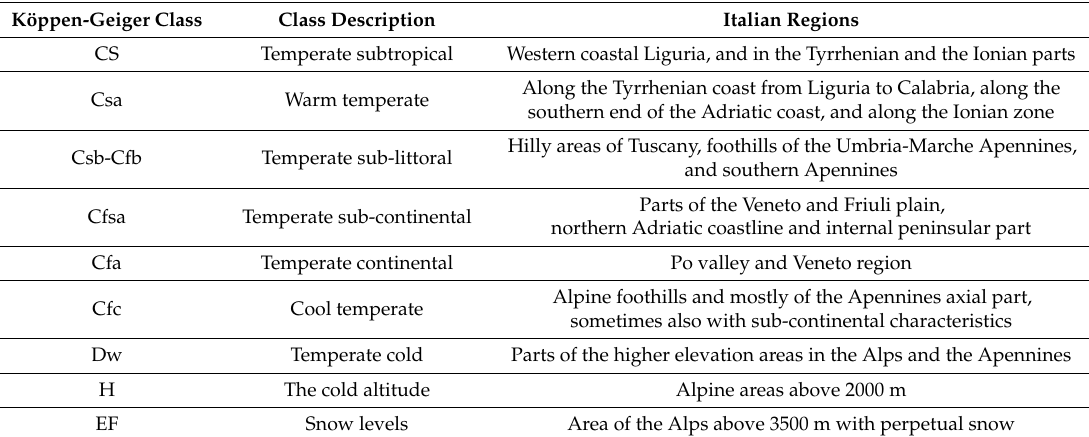
Table 1. Climates among the different regions within Italy territory (Figure 1b) identified by Pinna [44] following the Köppen-Geiger climate classification system